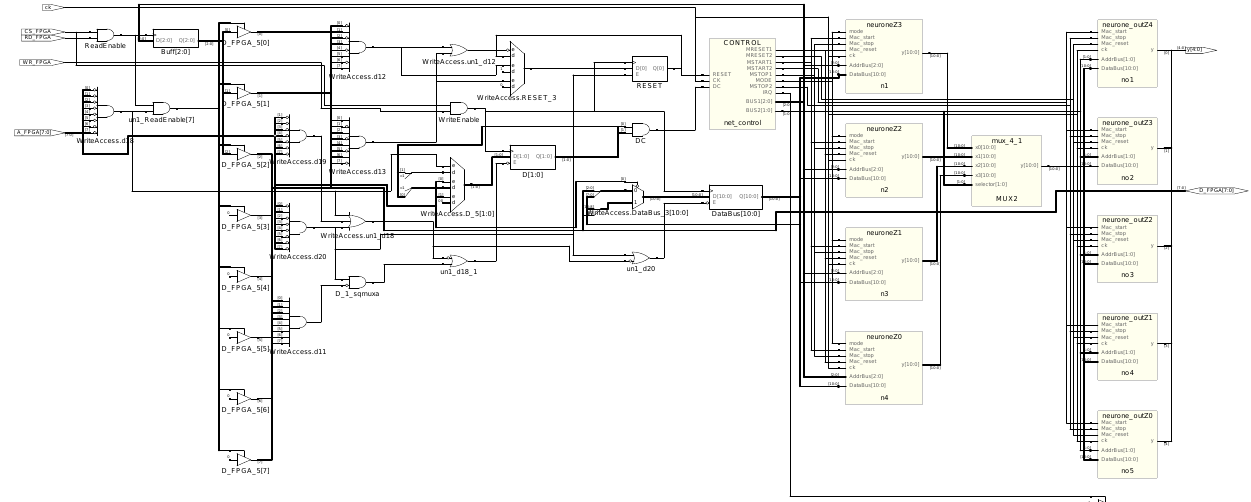
Figure 15. Synthesis result of the digital multilayer neural